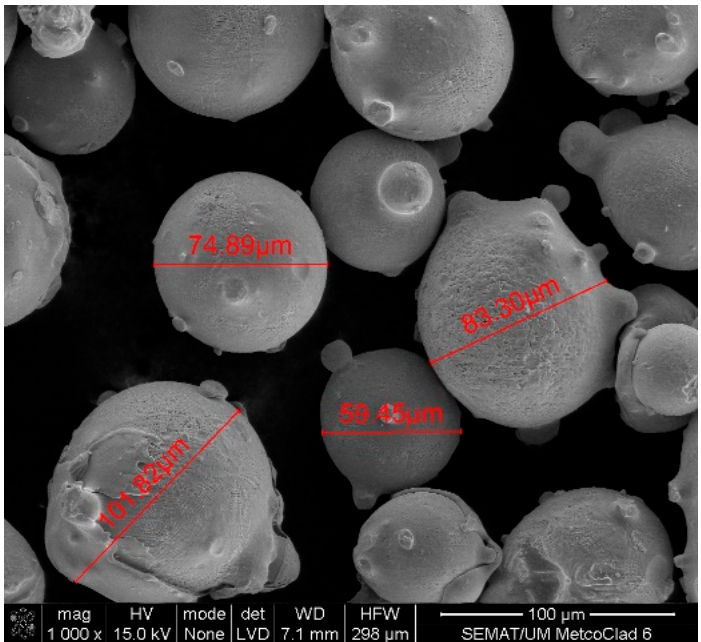
Figure 4. SEM analysis results: Raw Powder 1 sample—cobalt–chromium–silicon–carbon alloy.